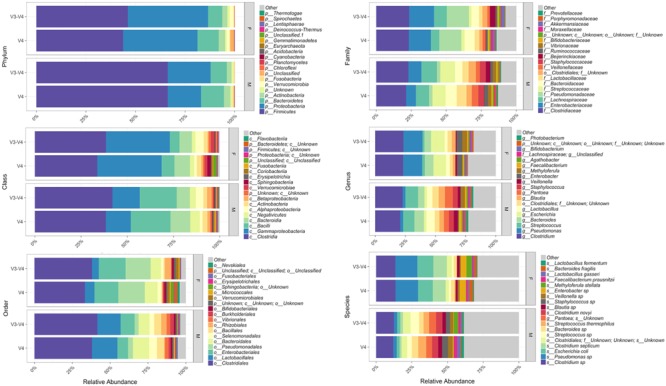
Relative abundances of the top most abundant bacteria in both 16S rRNA gene hypervariable region groups. Both region groups are illustrated according to taxonomic hierarchy and are faceted by gender.